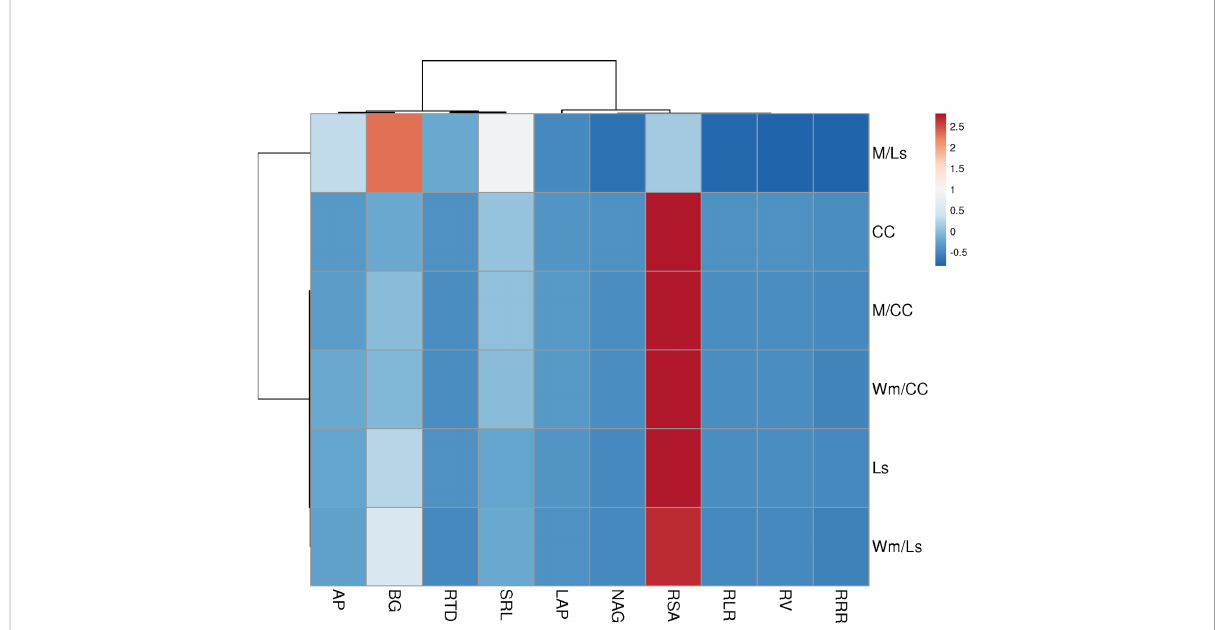
FIGURE 6 Clustered heatmap of root traits and enzyme exudation rate of AP, BG, LAP, and NAG of self-grafted Cucurbita maxima × Cucurbita moschata (CC), and Lagenaria siceraria (Ls) and of their heterografts with watermelon (Wm) and melon (M). Rows are centered; unit variance scaling is applied to rows. Both rows and columns are clustered using correlation distance and average